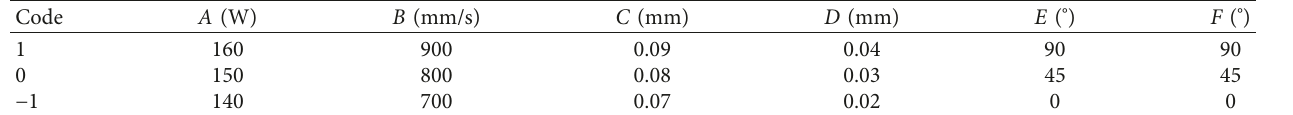
Table 2: Factor coding and experimental